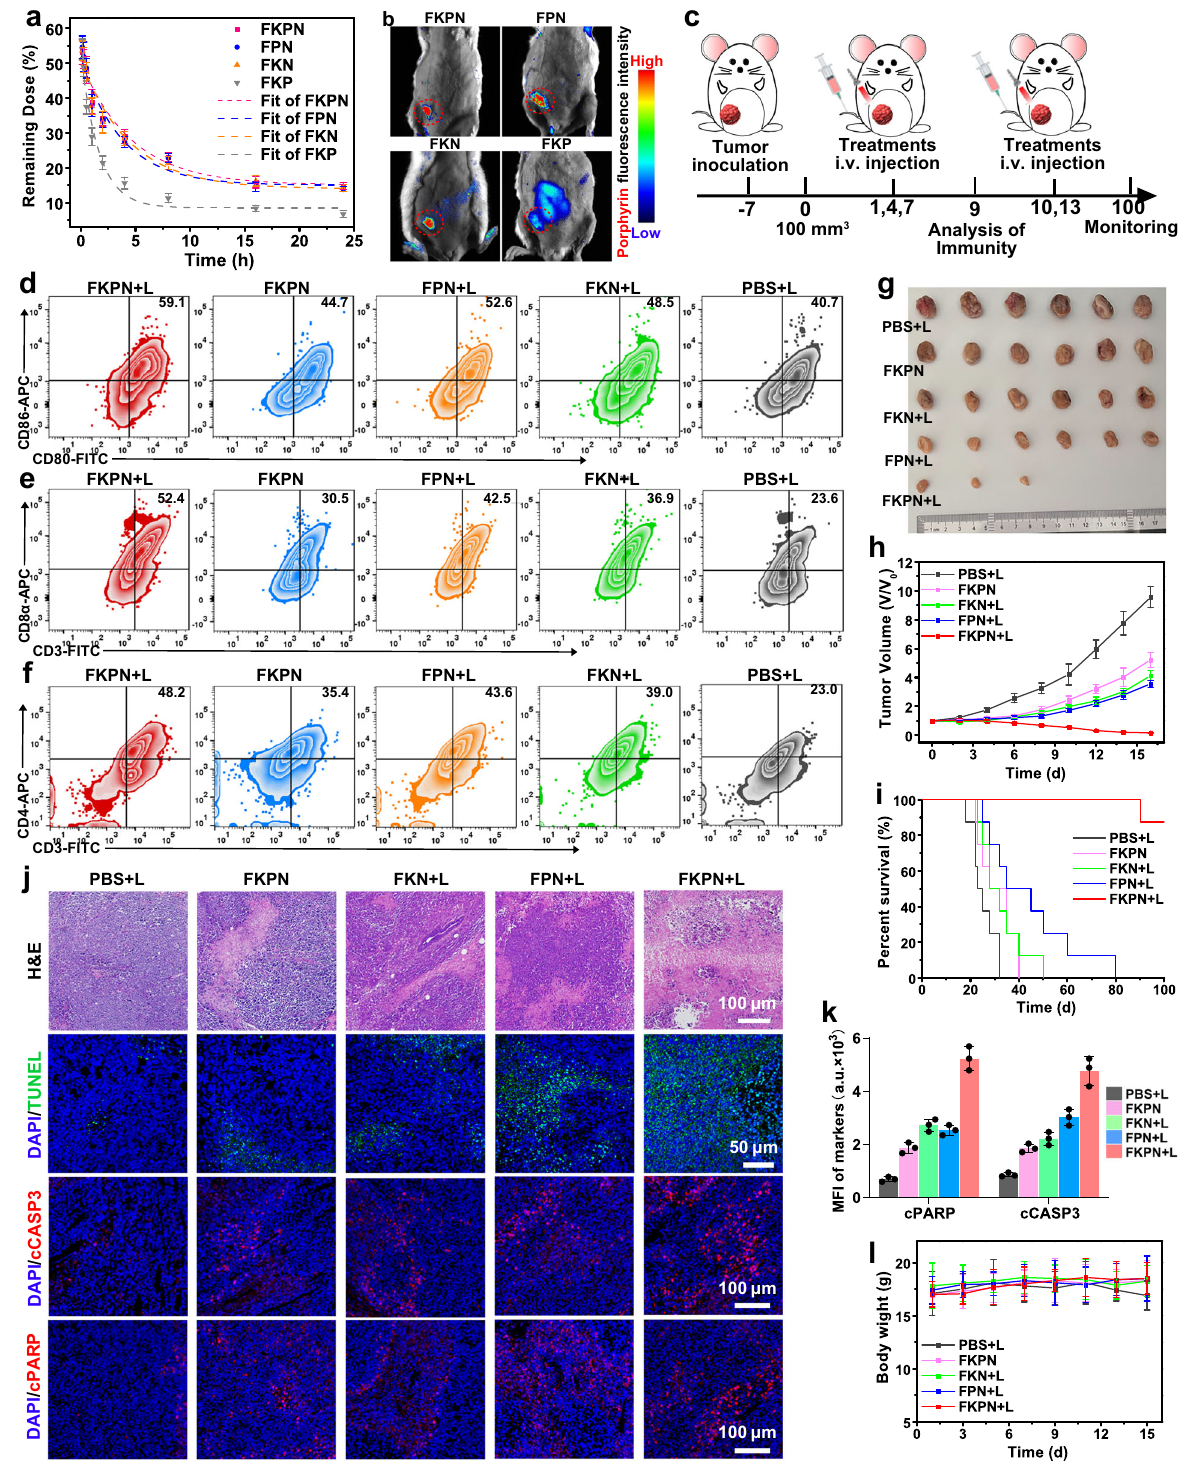
Fig. 5 | In vivo immune activation and antitumor effect of FKPN plus laser irradiation. a In vivo pharmacokinetic curves within 24h after intravenous injec- tion of samples. Data were presented as mean±SD ( n =3 mice). b In vivo fl uores- cenceimagesoftumor-bearingmiceafterbeinginjectedwithdifferentparticlesfor 3 days. Red: porphyrin fl uorescent. c Schematic illustration of treatment schedule using a 4T1 orthotopic breast cancer BALB/c mouse model. d Flow cytometry analysis of DC maturation in lymph nodes on day 9. Flow cytometric analysis of tumor-in fi ltrating e CD8 + T cells and f CD4 + T cells after various treatments. g Representative photographs of the tumors excised from tumor-bearing mice on day 16. ( n =6 mice). h Relative tumor volume change of 4T1 tumor models during